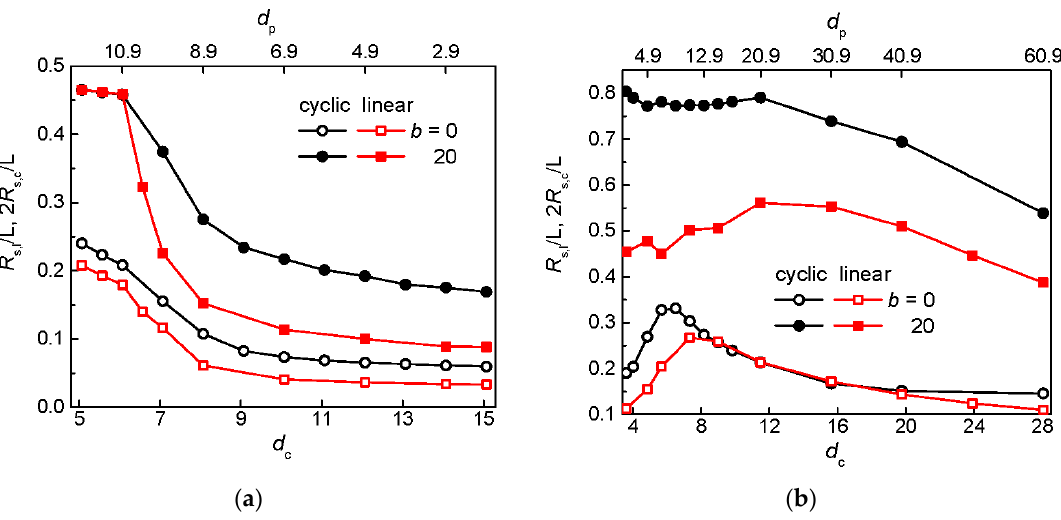
Figure 4. Relative extension along the posts for a flexible ( b = 0) and semiflexible ( b = 20) circular and linear chain in an array of posts of varying diameter d p separated by S p = 12 ( a ) and with passage width w p = 2 ( b ) as a function of the size of the interstitial space d c .